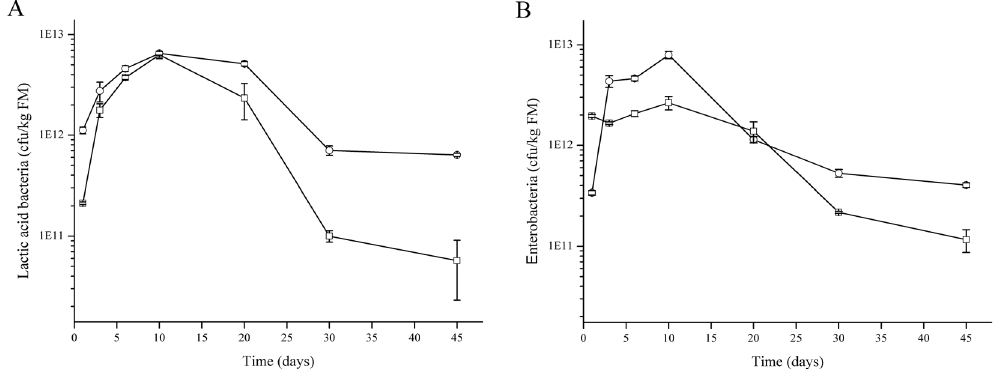
Figure 2. Counts of lactic acid bacteria ( A ) and enterobacteria ( B ) during ensilage. Treatments are inoculated silages ( ○ ) and controls ( □ ). FM represents fresh